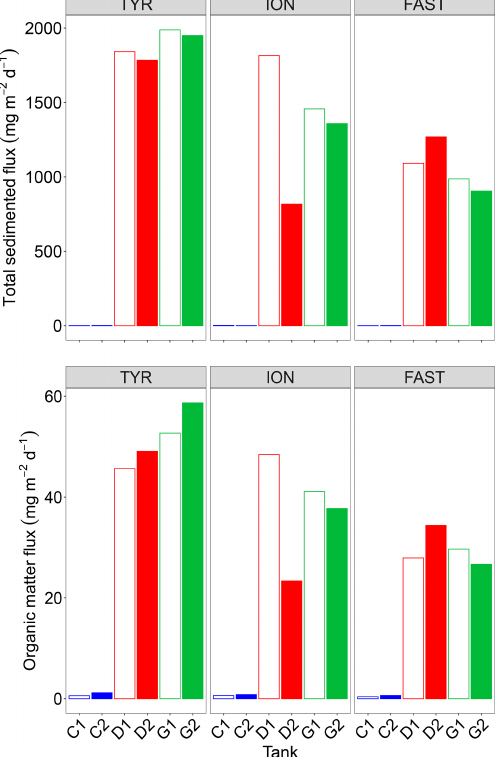
Figure 8. Total mass and organic matter fluxes measured in the sediment traps at the end of the three experiments (TYR, ION and FAST) in the six tanks (C1, C2, D1, D2, G1 and G2).